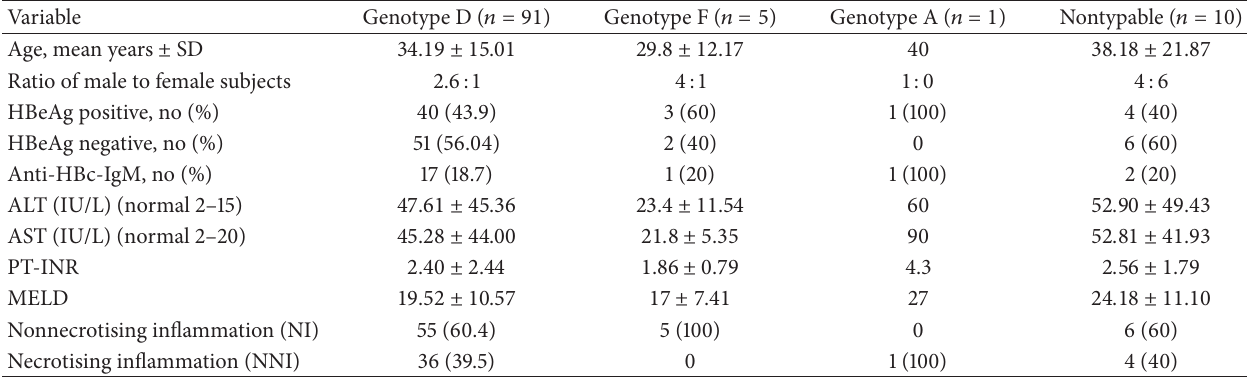
Table 2: Demographic profile, hepatitis B and antigen (HBeAg) status, and biochemical profile of patients with different HBV genotypes.